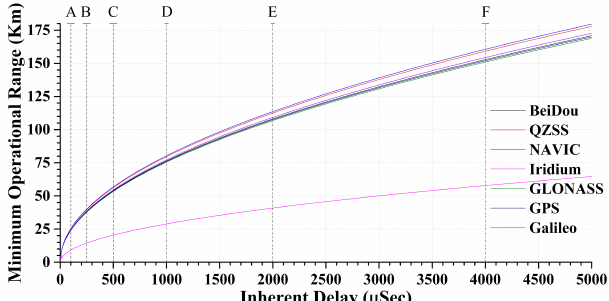
Figure. 3. The Minimum Operaional Range for RDS with differect inherent delays.